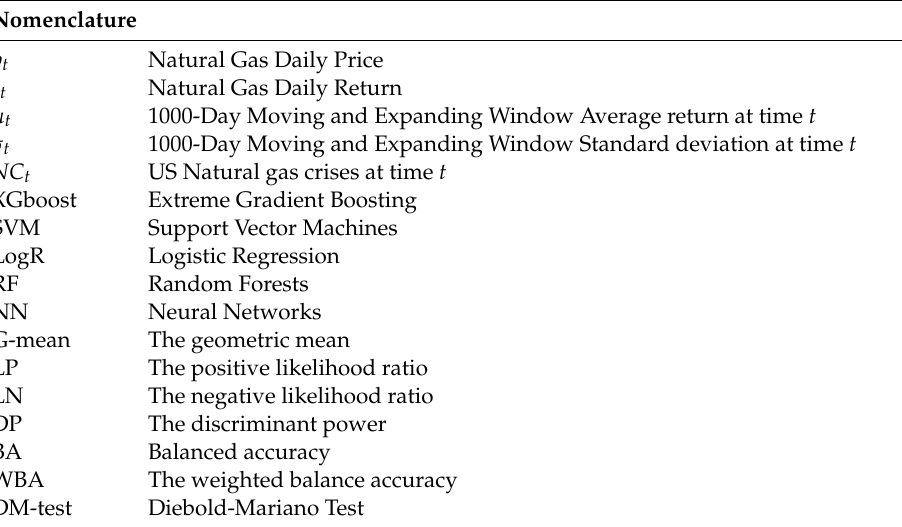
Table 2. Nomenclature for professional items.